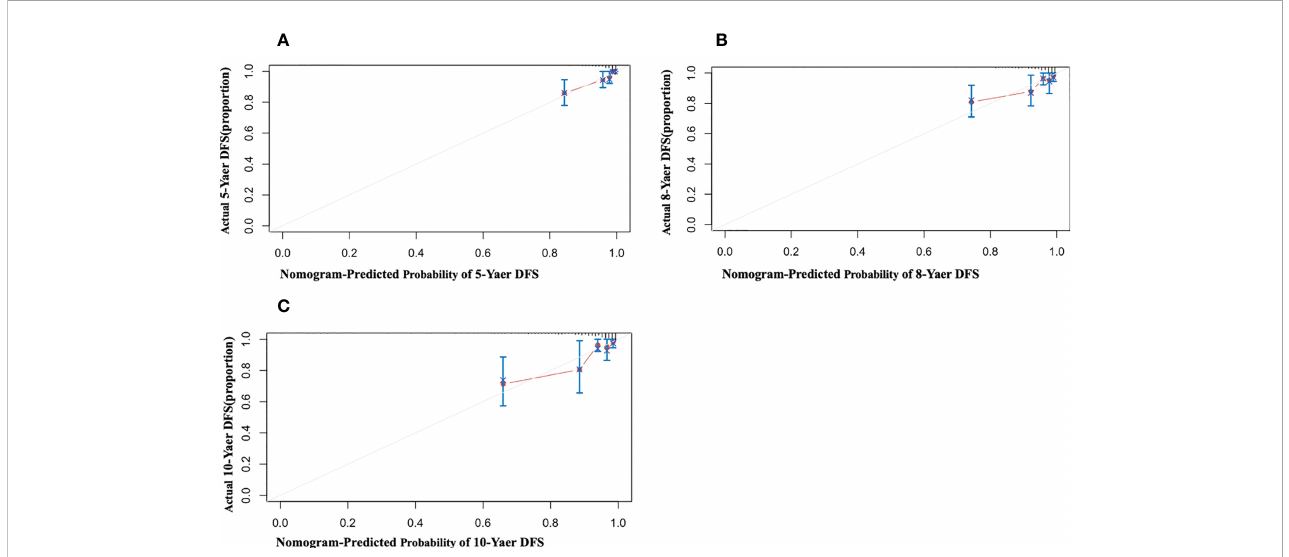
FIGURE 5 Calibration of the nomogram for Risk of ESRD in IgAN. The x-axis shows the predicted probability of risk of ESRD in IgAN, and the y-axis shows the observed probability of risk of ESRD in IgAN. (A) Nomogram of 5-year calibrated risk of ESRD in IgAN. C-index:0.862; (B) Nomogram of 8-year calibrated risk of ESRD in IgAN. C-index:0.838; (C) Nomogram of 10-year calibrated risk of ESRD in IgAN. C-index: